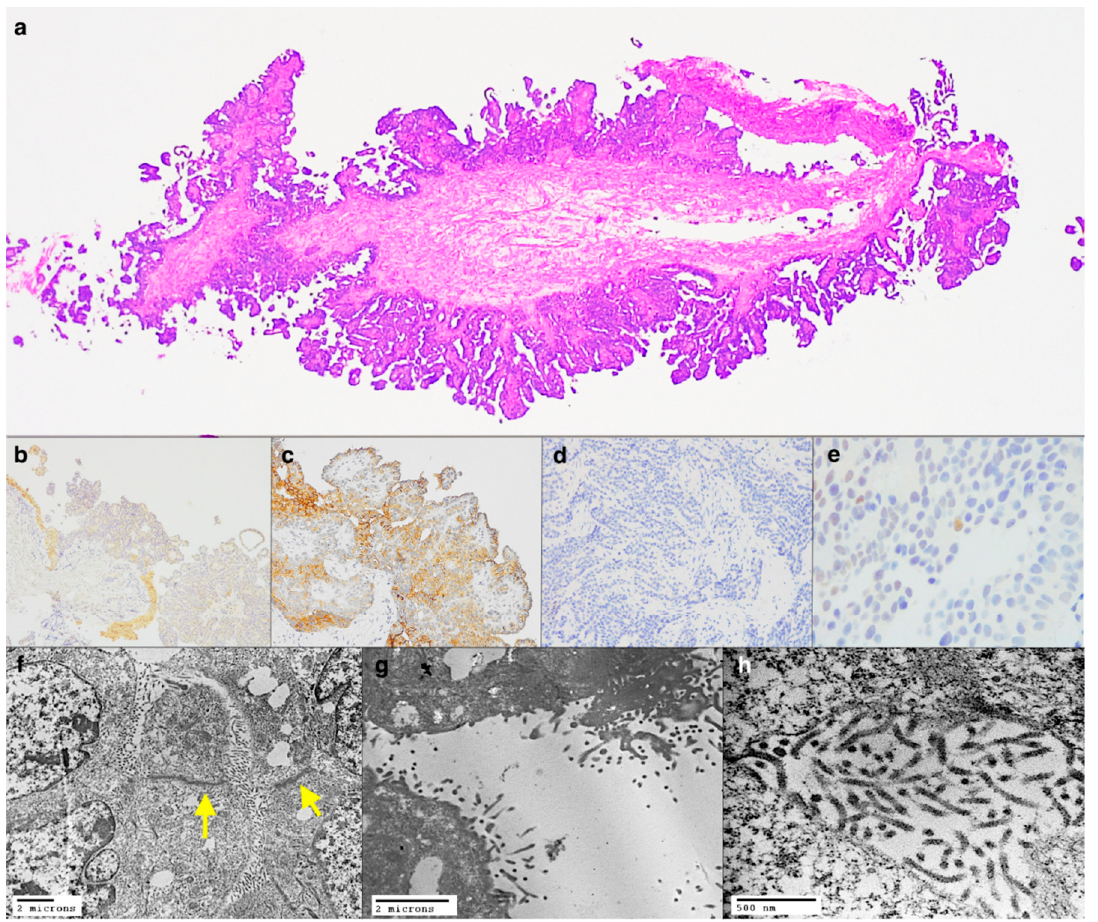
Figure 3. Panoramic view of the pleural biopsy showing a papillary proliferation ( a , haematoxylin and eosin stain, original magnification ×25). Immunohistochemistry showing weak positivity for Calretin ( b , immunoperoxidase staining, original magnification ×100), D2-40 ( c , immunoperoxidase staining, original magnification ×200), loss of nuclear expression of BAP1 ( d , immunoperoxidase staining, original magnification ×200), and rare cells positive for estrogen receptor ( e , immunoperoxidase staining, original magnification ×400). TEM showing tight junctions (yellow arrows) and branched and elongated microvilli ( f – h , original magnification ×3500, ×7000, ×30,000).